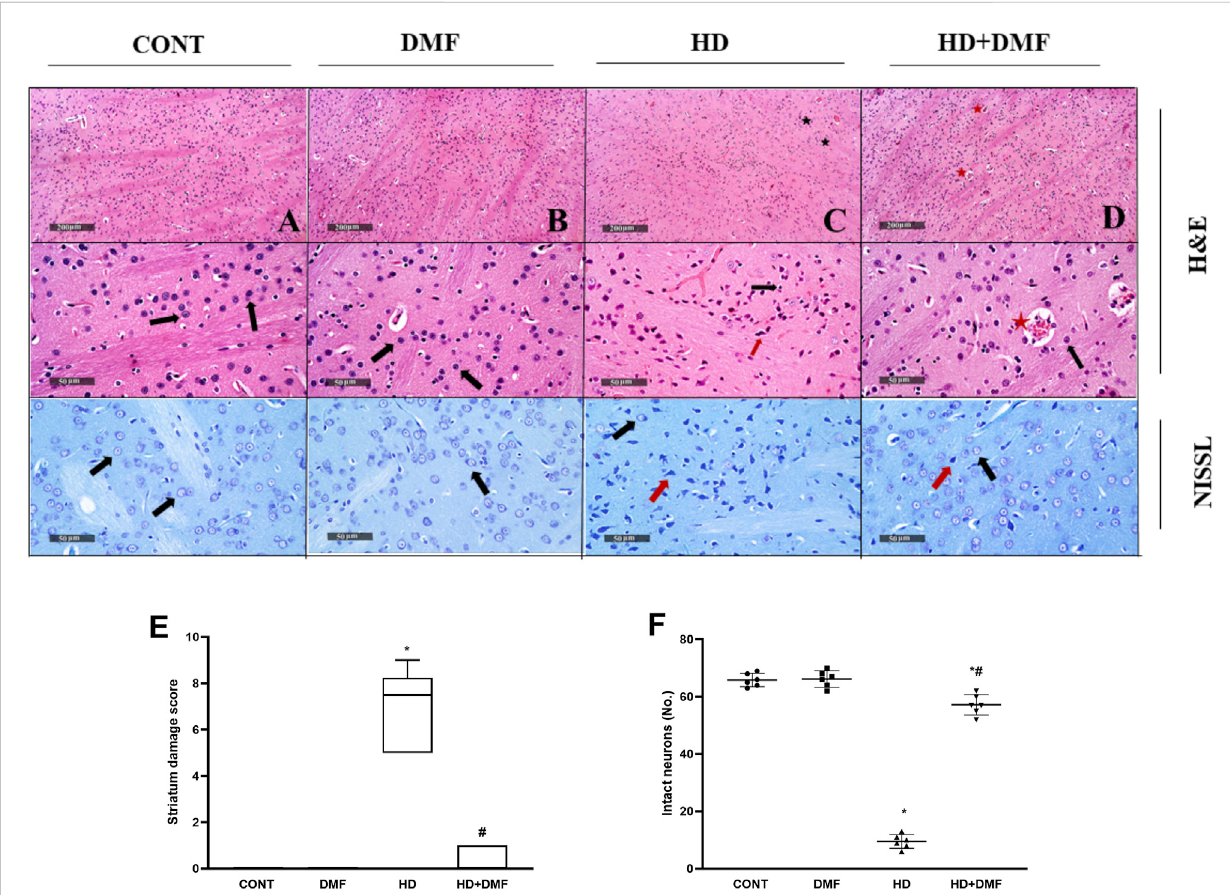
Effect of DMF on striatal histological changes induced by HD. (A) CONT micrograph showing ordinary histological architecture (black arrow s); (B) DMF showing no abnormal fi ndings; (C) HD showing bountiful degeneration of neurons with contracted pyknotic neuronal cell bodies (red arrow), moderate blood vessel congestion (star) , and slight in fi ltration of focal glial cells (black arrow ) ; (D) HD + DMF showing marked improvement of morphological features with intact neurons and subcellular components (black arrow) with moderately congested blood vessels (star) . The data (six non-overlapping fi elds; n = 3 rats/group) in panel (E) represent the striatum damage score that is represented as dot boxplots displaying minimum, maximum, median, and the fi rst and third quartiles, and statistically analyzed by non-parametric Kruskal – Wallis and Dunn ’ s post hoc tests, whereas the panel (F) presentsameannumberofNissl-stainedcells(intactneurons)±SDtestedforsigni fi canceusingone-wayANOVA,followedbyTukey ’ s posthoc test; * vs. CONT and # vs. HD at p < 0.05. CONT, control; DMF, dimethyl fumarate; HD, Huntington ’ s